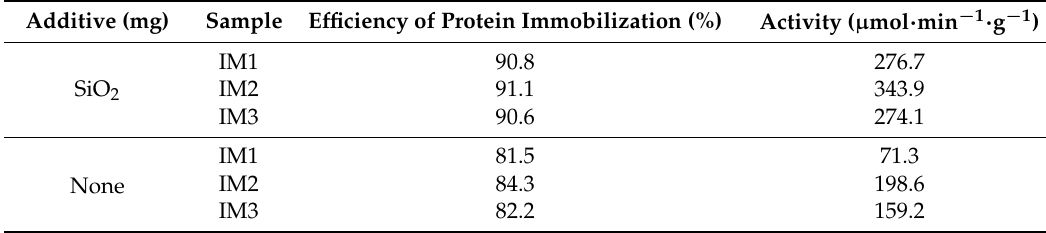
Table 3. The effect of PVA (polyvinyl alcohol) and PEG (polyethylene glycol) on the activity and efficiency of protein immobilization.